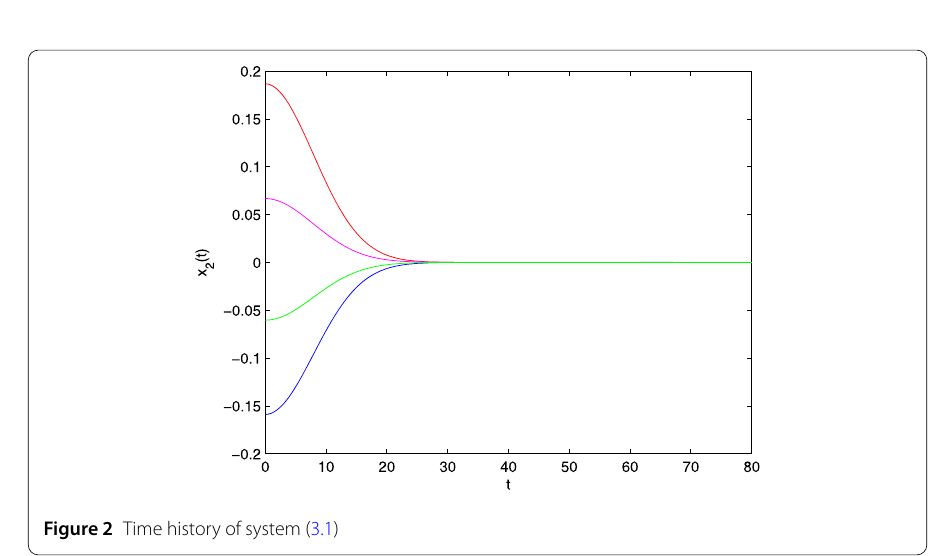
Figure 1 Time history of model (3.1)